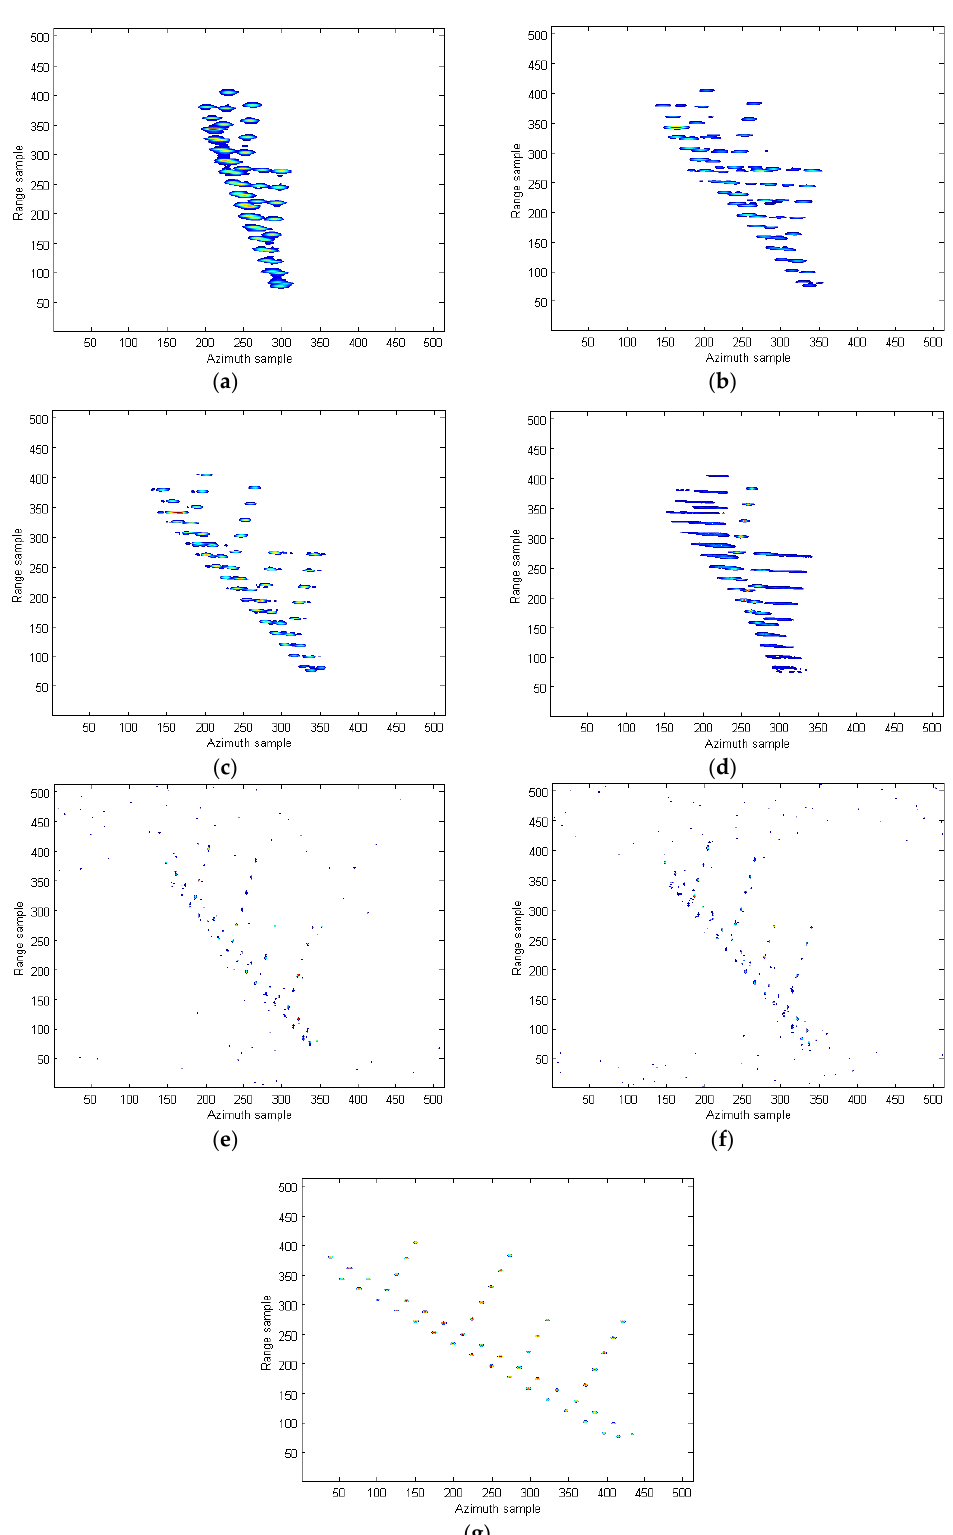
Figure 10. ISAR images of the simulated data under SNR = 5 dB. ( a ) STFT algorithm in [10]; ( b ) WVD